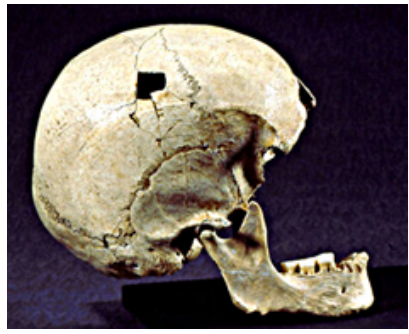
Figure 3. Stetten 2, from the Vogelherd Cave, Germany: “African Eve” advocates believed it to be of the Aurignacian; it is in fact from a Neolithic